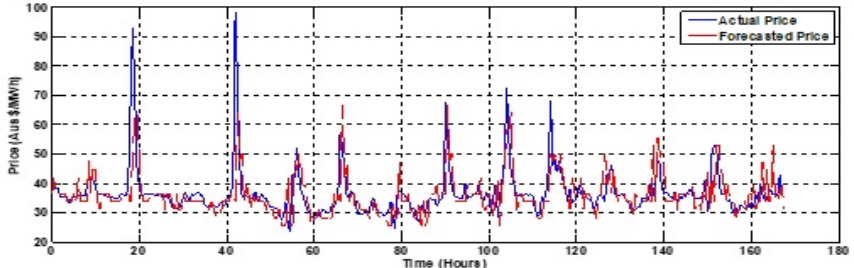
Figure 6. August 8–14, 2015 forecasting, while maximum number of features selected in the winter season (MAPE = 10.22).